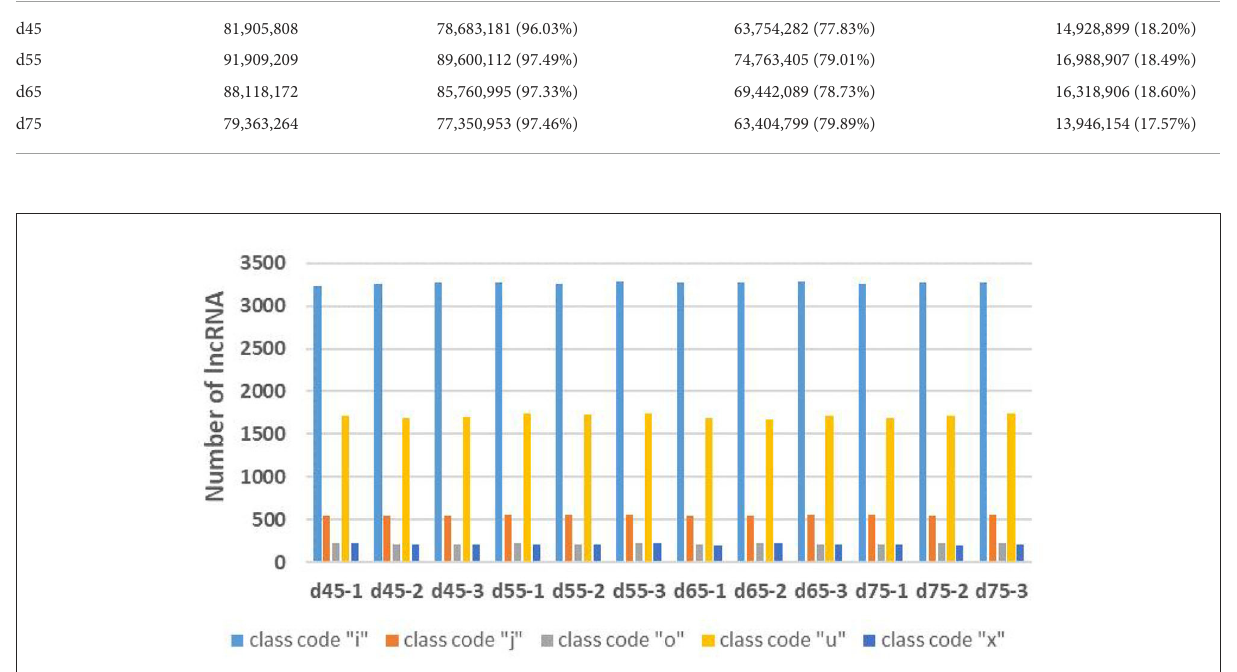
FIGURE1 The statistics of different types of lncRNAs in the embryonic stage of Inner Mongolia cashmere goat. The blue column represents the “i” class lncRNA, the orange column represents the “j” class lncRNA, the gray column represents the “o” class lncRNA, the yellow column represents the “u” class lncRNA, and the dark blue represents the “x” class